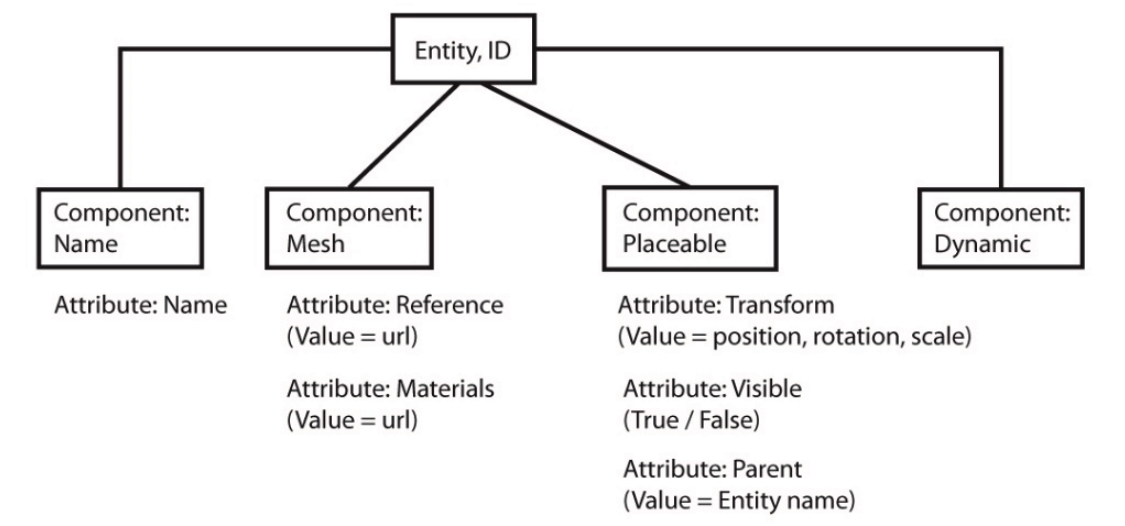
Figure 1. Sample object composition using the scene-entity-component-attribute